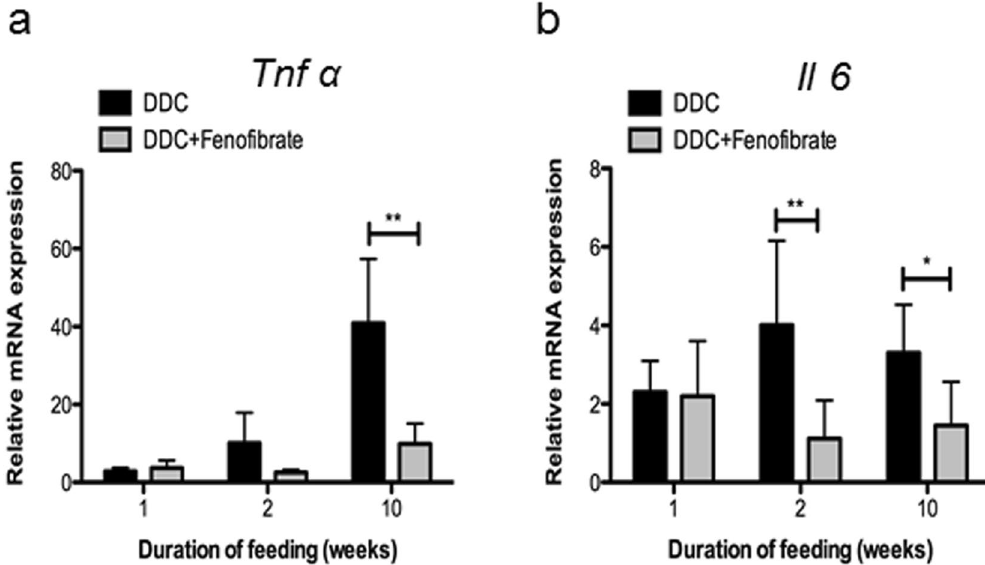
Figure 6. Fenofibrate reduces expression levels of inflammatory genes: ( a ) Tnf α ; ( b ) Il6 . Quantitative RT-PCR was performed with mRNA extracted from whole liver tissue. Data are given as fold-change relative to controls represented as mean ± SD collected from five animals per treatment group. Significances of DDC intoxication stages are shown versus co-administration of DDC and fenofibrate: * p < 0.05; ** p <